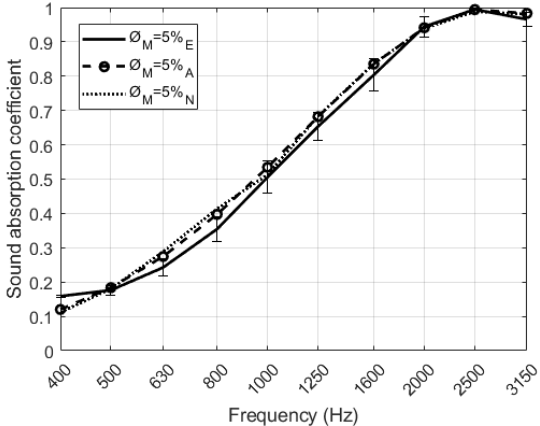
Table 3. Acoustic parameters of the samples measured. Bulk density of the material ( 𝜌 (cid:3040) ) , density of the fibers ( 𝜌 (cid:3033) ), airflow resistivity ( σ ), porosity (ø), meso-porosity ( ø (cid:3014) ) , tortuosity ( 𝛼 ∞ ) , viscous characteristics length ( Λ ), thermal characteristics length ( 𝛬 (cid:4593) ), and mean fiber diameter (d). Foam Type